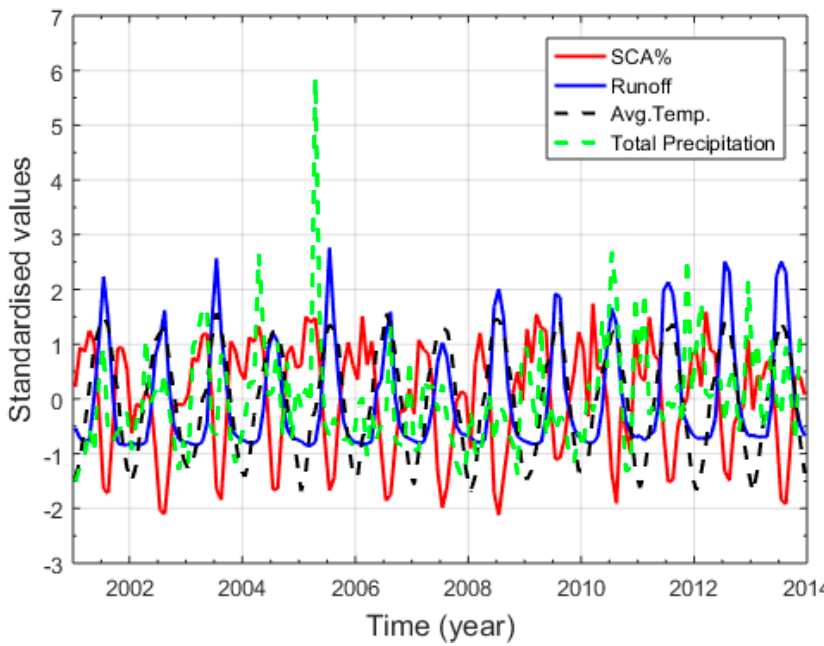
Figure 8. Standardized values of runoff, SCA, precipitation, and average temperature.